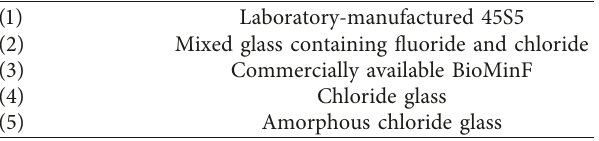
Table 1: Five different types of bioactive glass formulations used for the study.